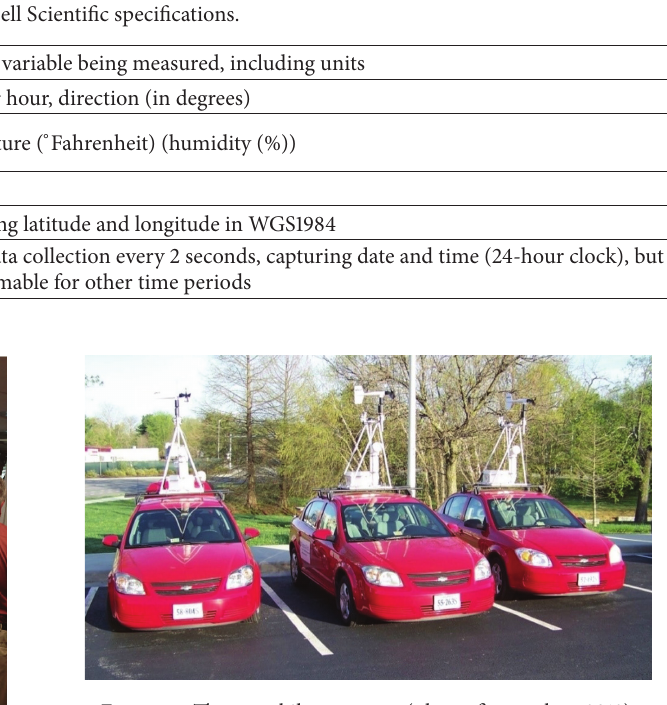
Figure 7: Three mobile mesonets (photo, first author, 2013).